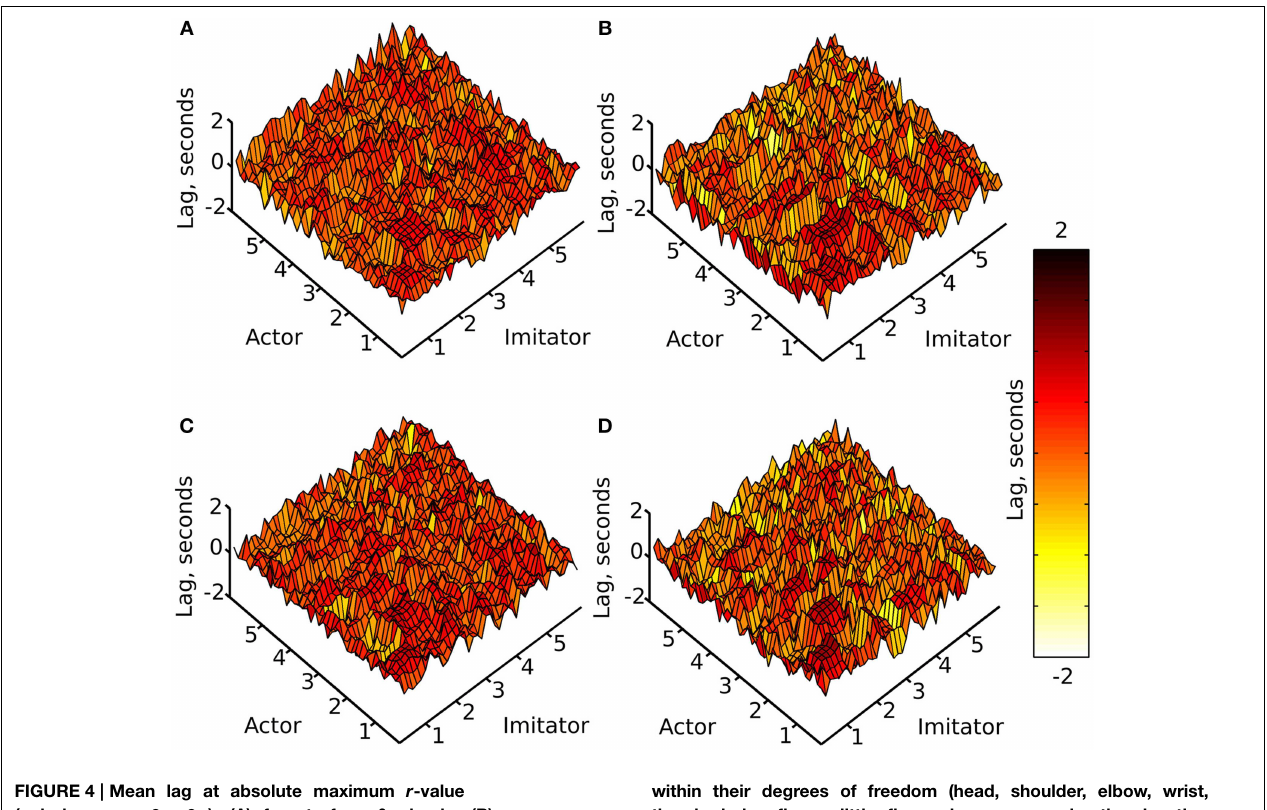
within their degrees of freedom (head, shoulder, elbow, wrist, thumb, index finger, little finger, in x, y, z, azimuth, elevation, and roll): 1 = x, 2 = y, 3 = z, 4 = azimuth, 5 = elevation, 6 = roll.